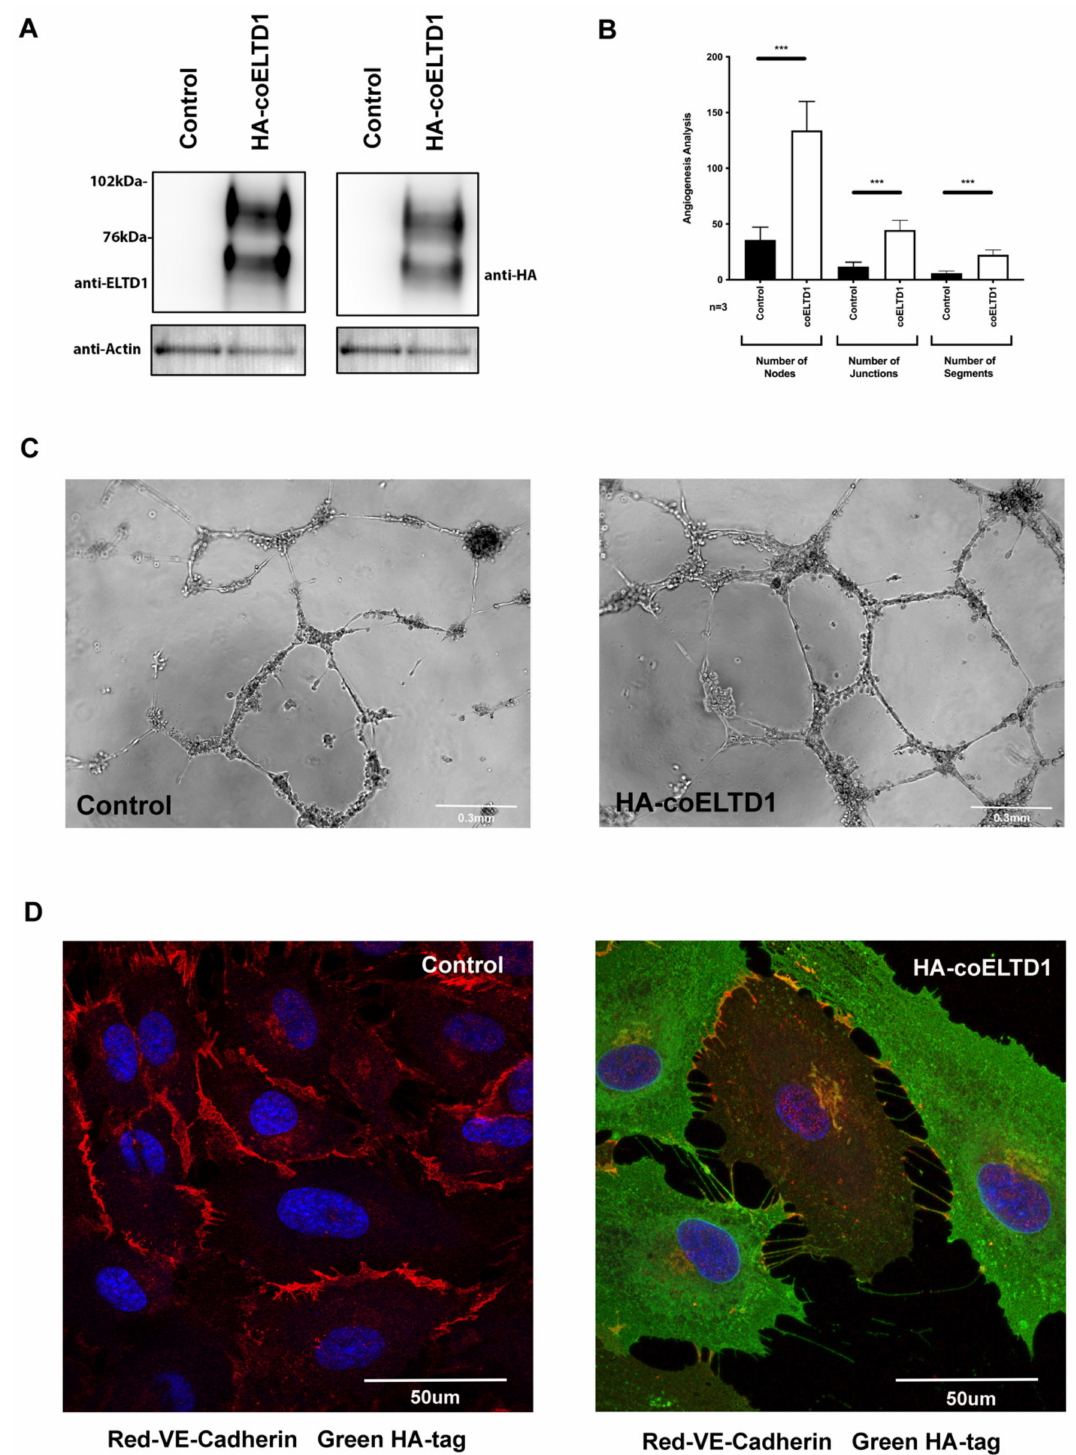
Figure 3. HA and FLAG tagging of coELTD1. ( A ) Western blot of HUVEC cells transduced with control versus HA-tagged coELTD1 expressing lentivirus probed with anti-ELTD1 and anti-HA tag antibodies. ( B , C ) Matrigel assay of control versus HA-tagged coELTD1 expressing HUVEC with quantification of network formation. ( D ) Fluorescent staining of VE-Cadherin and HA-tagged coELTD1 in control and HA-coELTD1 expressing HUVEC cells at 120 h. Images were taken on a Zeiss LSM 880 Confocal Microscope (Zeiss) at 63 × magnification. *** p